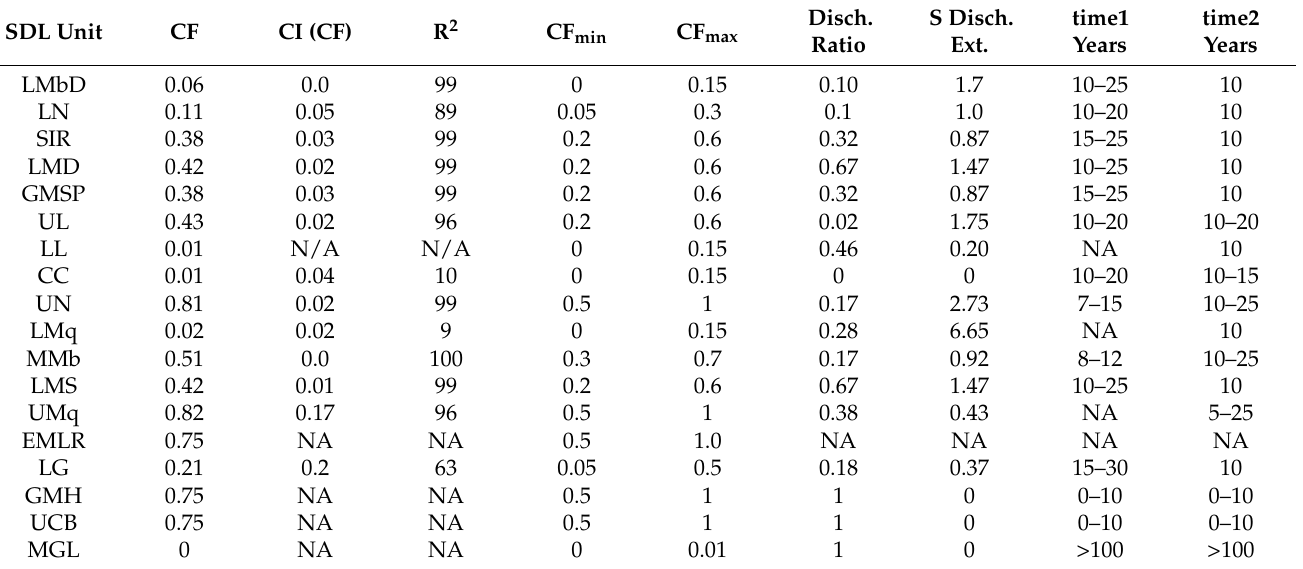
to stressor; and the time lag calculated by Equation (6) (time1) and by visual inspection